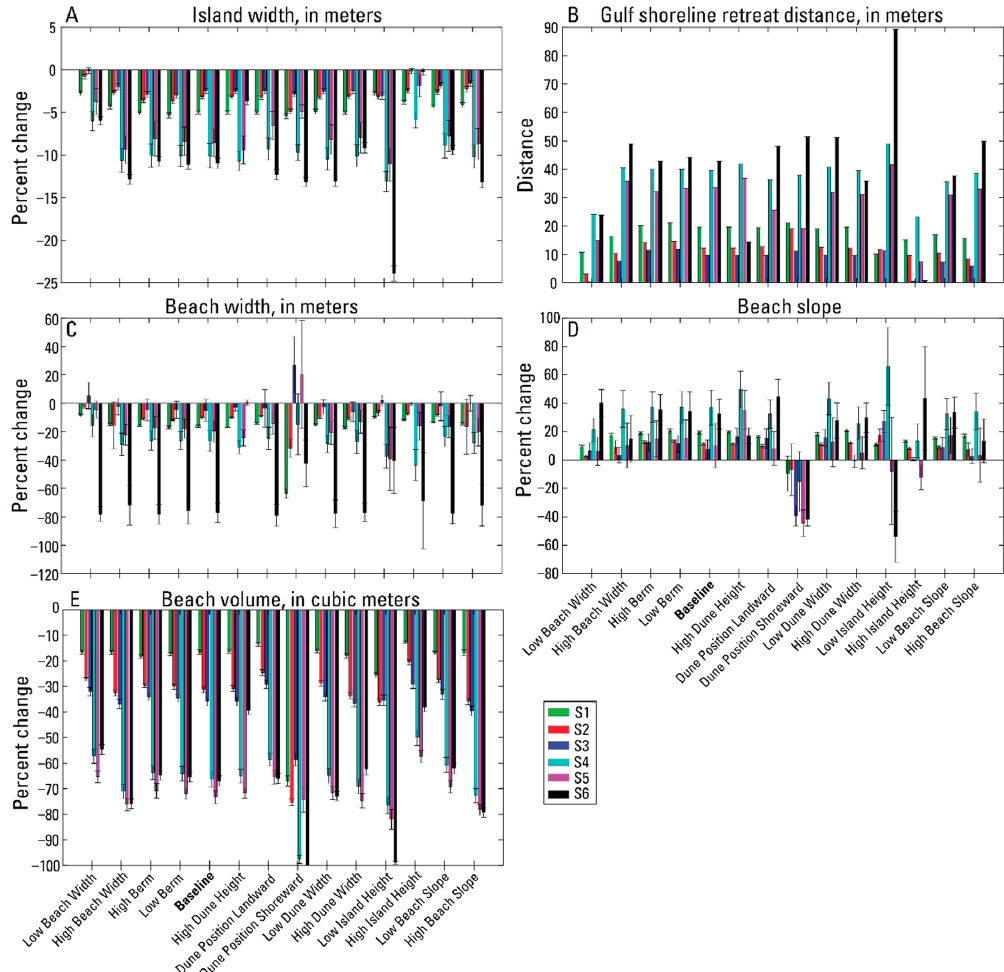
Figure 11. 2D post-storm percent changes to the alongshore averaged (with error bars of standard deviation) island width ( A ), beach width ( C ), beach slope ( D ), and beach volume ( E ) for storms 1 through 6 (S1–S6). 2D post-storm alongshore averaged gulf shoreline retreat distance ( B ). Metrics are provided in the panel titles to indicate those features that were analyzed, not the values presented in the graphs. Note: y -axis scales differ among panels.